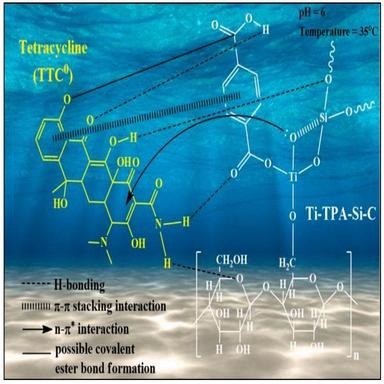
Diagram illustrating the mechanism of adsorption between adsorbents and TTC antibiotic.